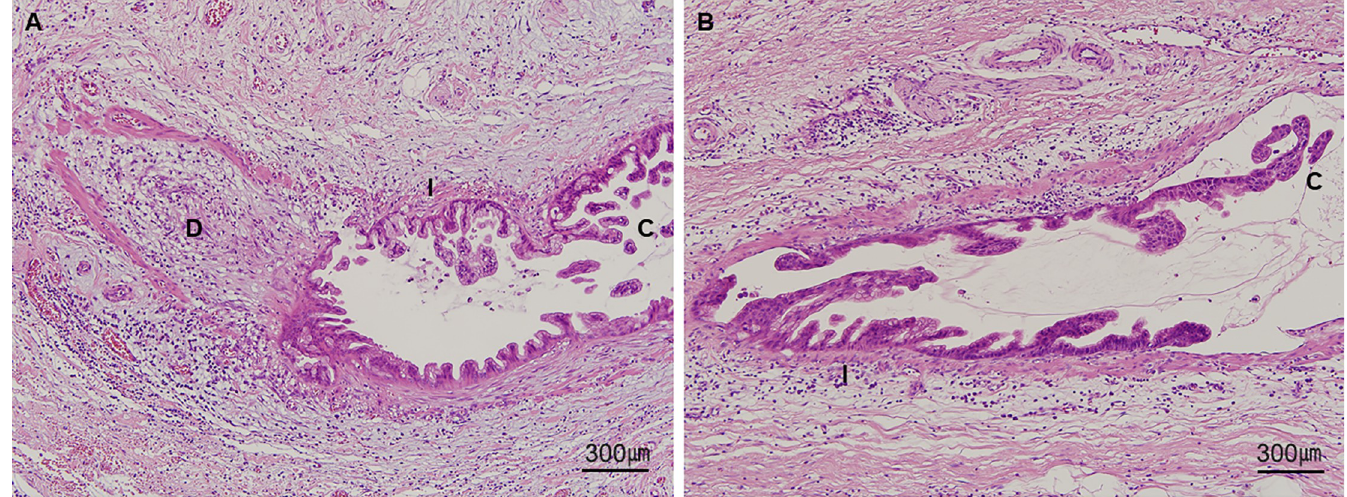
Fig 5. Representative images of mixed patterns of VI. (A) A focus of VI showing all three patterns—destructive (D), IN-like (I), and conventional (C). This rapid transition from destructive to IN-like and finally to conventional patterns suggests that these three patterns are strongly associated between each pattern. (B) VI exhibiting mixed patterns showing transition from IN-like (I) to conventional (C) patterns (all, × 100 magnification).